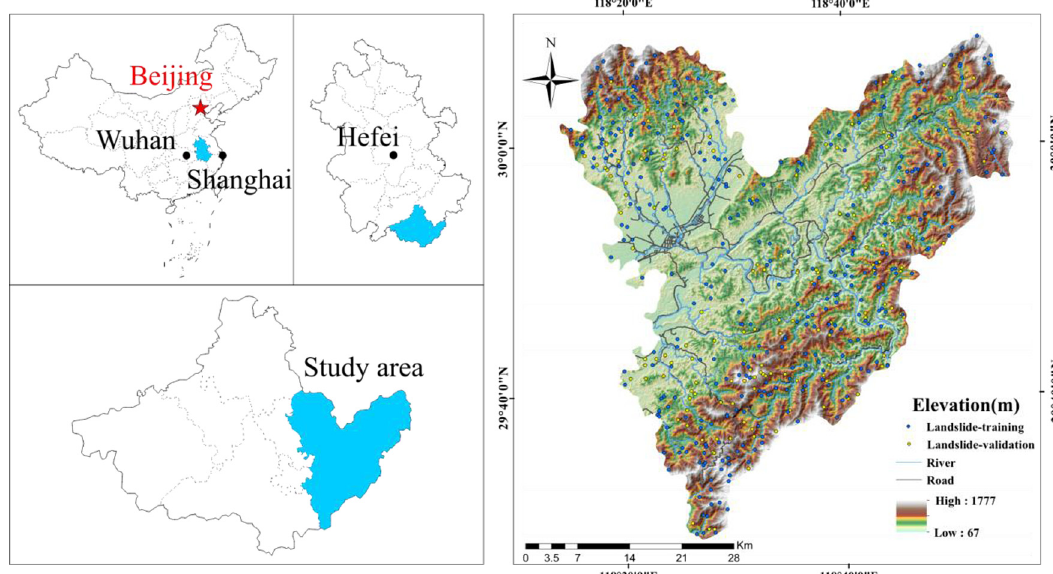
Figure 1: Location of the study area and landslide inventory